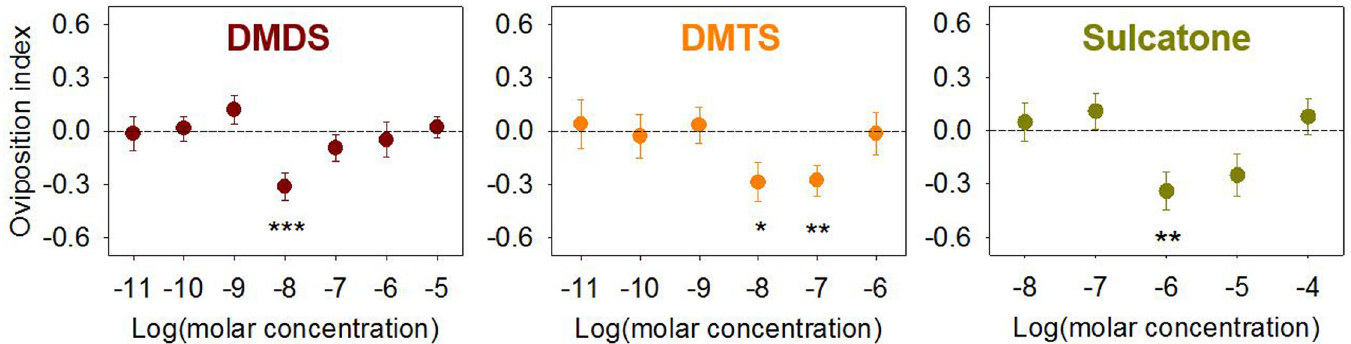
Fig 3. Oviposition behavior of An . coluzzii gravid females is negatively affected by DMDS, DMTS and sulcatone. An . coluzzii gravid females were allowed oviposit between control water and DMDS, DMTS and sulcatone with serial dilutions. Asterisks represent significant OI value different from zero ( ** , p < 0.01; * , p < 0.05; Wilcoxon signed-rank test, two-sided). Error bar = s.e.m. (n = 14 ~ 35).